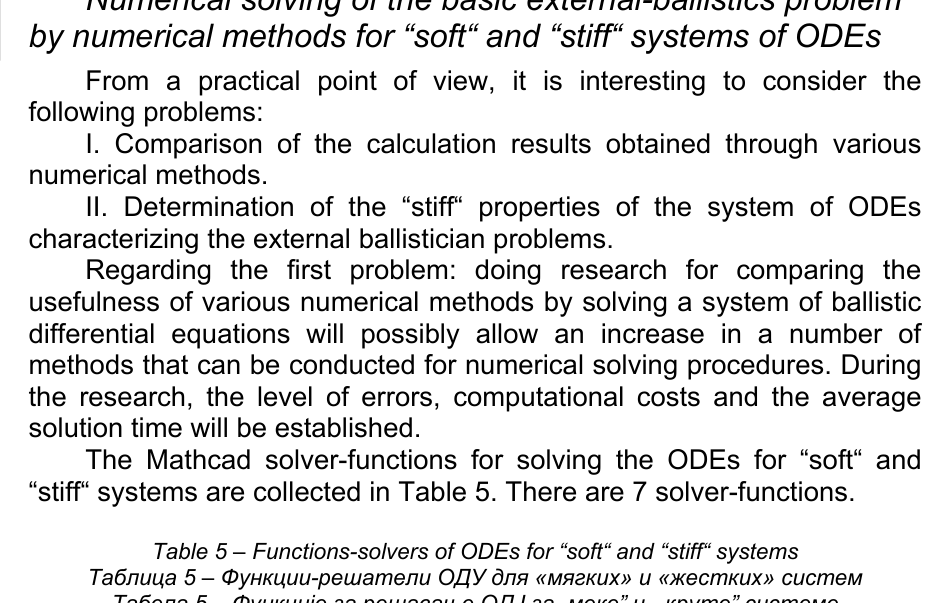
Table 5 – Functions-solvers of ODEs for “soft“ and “stiff“